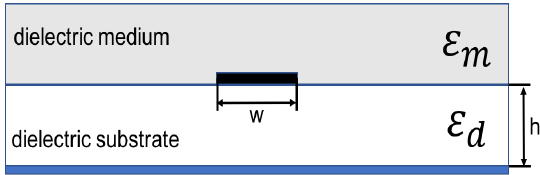
Figure 8. Basic microstip